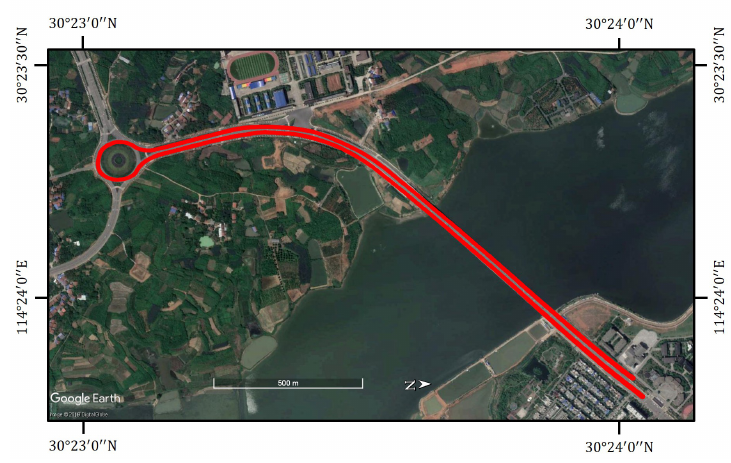
Figure 18. Experimental data. Trajectories in the Jiangxia District in the city of